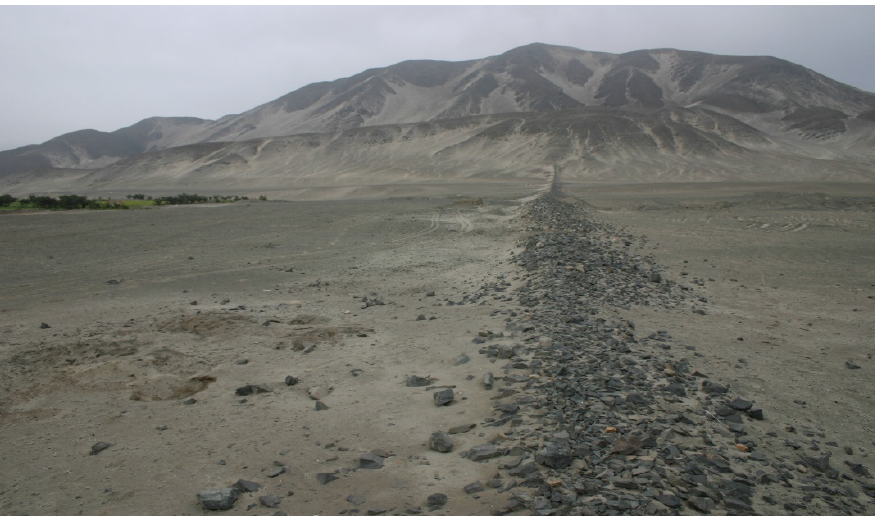
Figure 28. A further stone wall aeolian sand transfer barrier placed at the Ostra base camp to the north of the Santa Valley; such defenses were typical of preceramic societies in the north central coast.